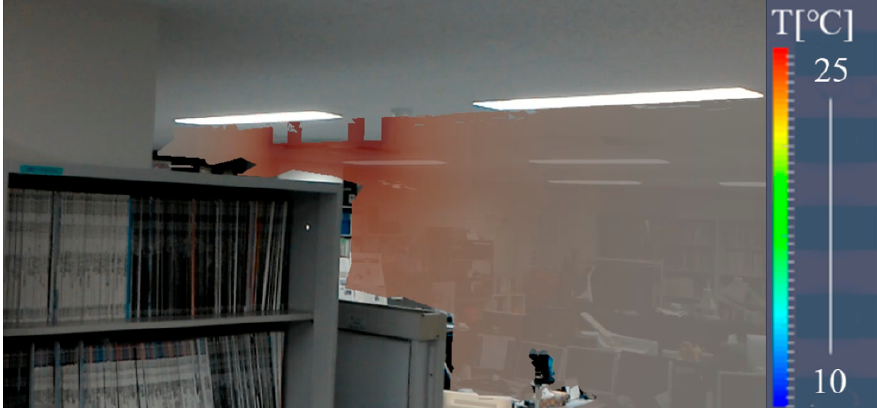
Figure 3. HMD view of room 411 small-scale model (1/10) using computational fluid dynamics (CFD) results.